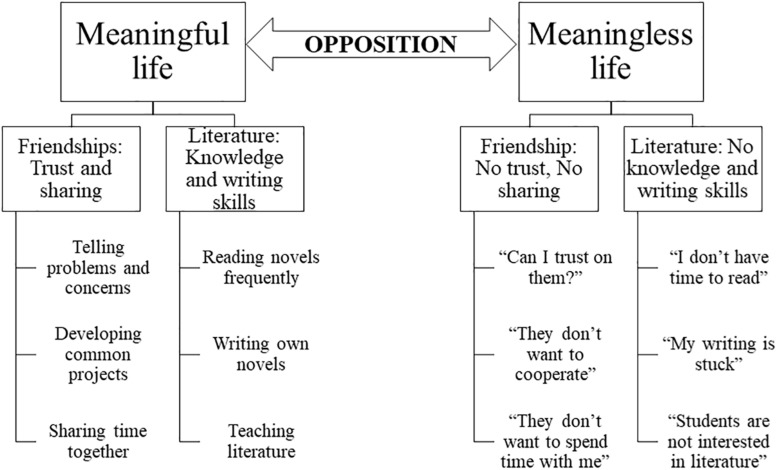
Example of a hierarchical network of positive reinforcers (left) and negative reinforcers that might function as triggers for engaging in RNT (right).